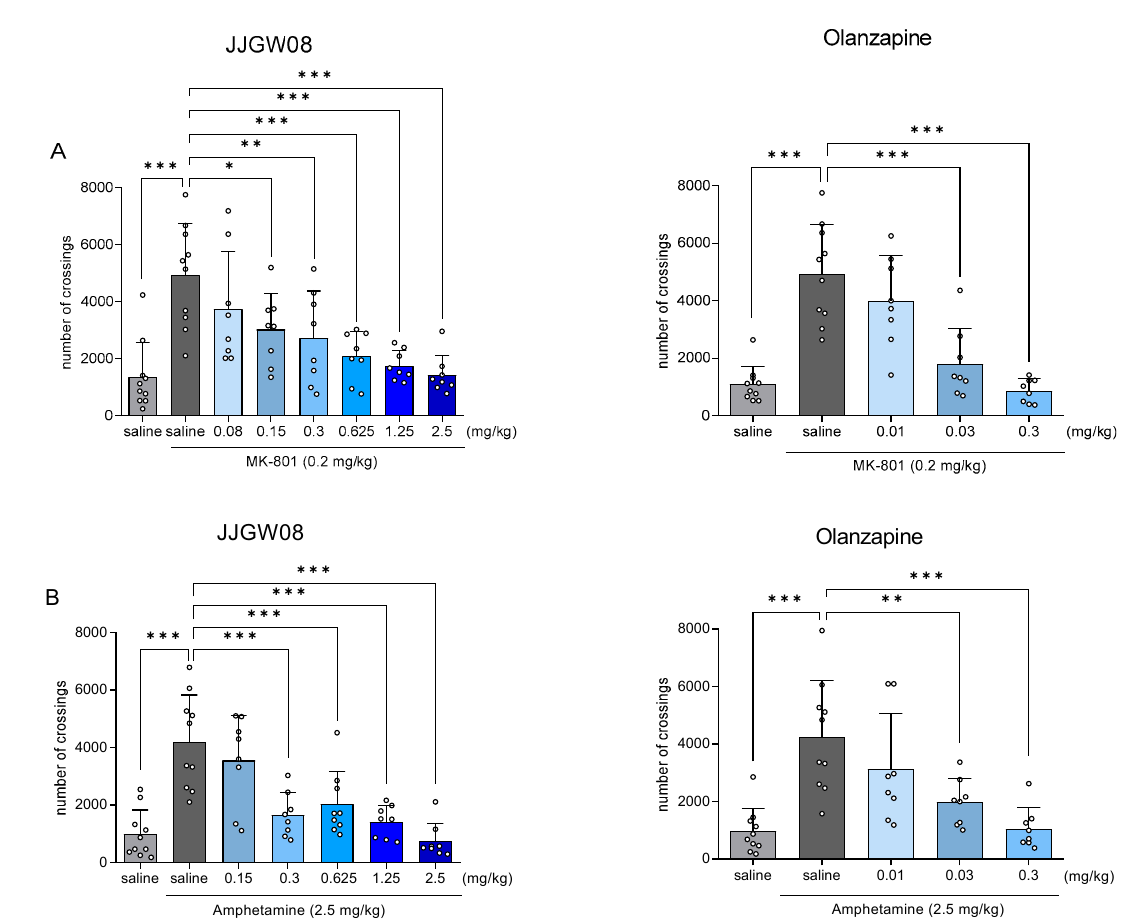
Figure 1. The effect of JJGW08 and olanzapine on the MK-801- (Panel ( A )) and amphetamine-induced (Panel ( B )) hyperlocomotion in mice. Locomotor activity was recorded in actometers separately for each mouse. After 30 min of adaptation, the number of crossings of photo beams was measured during 60 min. JJGW08 and olanzapine were administered intraperitoneally ( ip ) 30 min before the test. MK-801 (0.2 mg/kg, ip ) was administered 15 min before the experiment, while amphetamine (2.5 mg/kg) was administered subcutaneously ( sc ) 30 min before the experiment. The control group received two injections of 0.9% NaCl ( ip or sc ) or 0.9% NaCl and 1% Tween in the case of olanzapine. Values are expressed as means ± SD, n = 8–10 mice per group. Statistical analysis: one-way ANOVA (Newman–Keuls post hoc ), * p < 0.05, ** p < 0.01, *** p < 0.001.